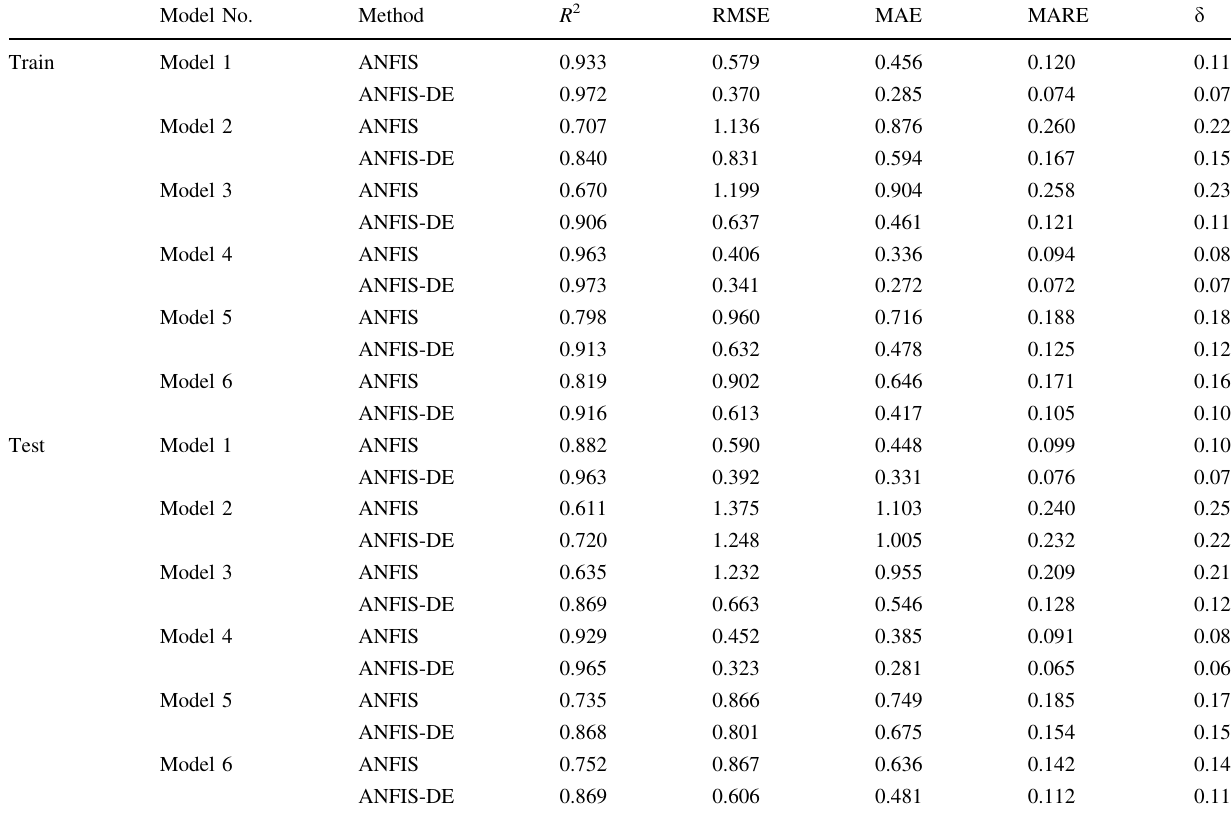
Table 2 Performance evaluation of ANFIS and ANFIS-DE in predicting Fr for all models (training and testing) Model No.